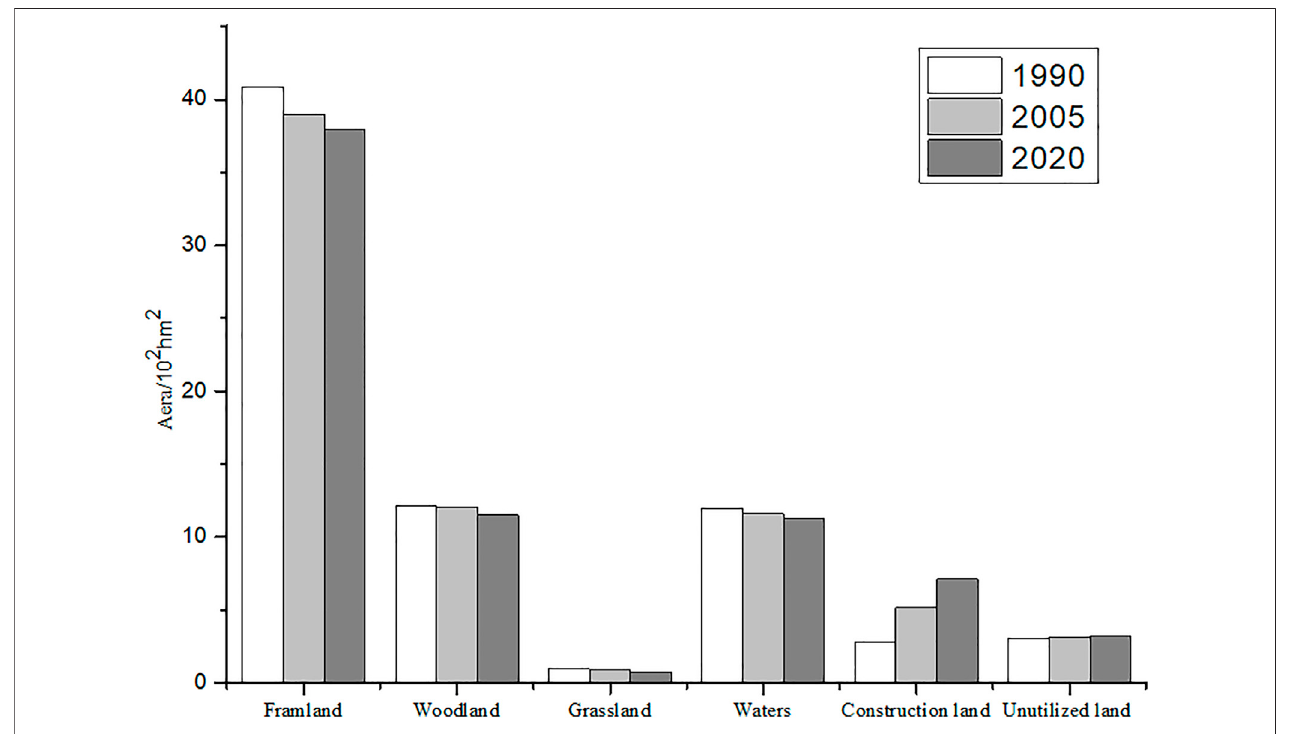
FIGURE 4 | Land-use area of the fi rst classes in 1995, 2005, and